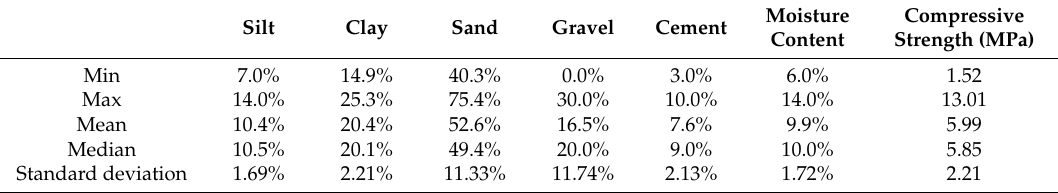
Table 2. Composition and the compressive strength of 434 tested samples—basic